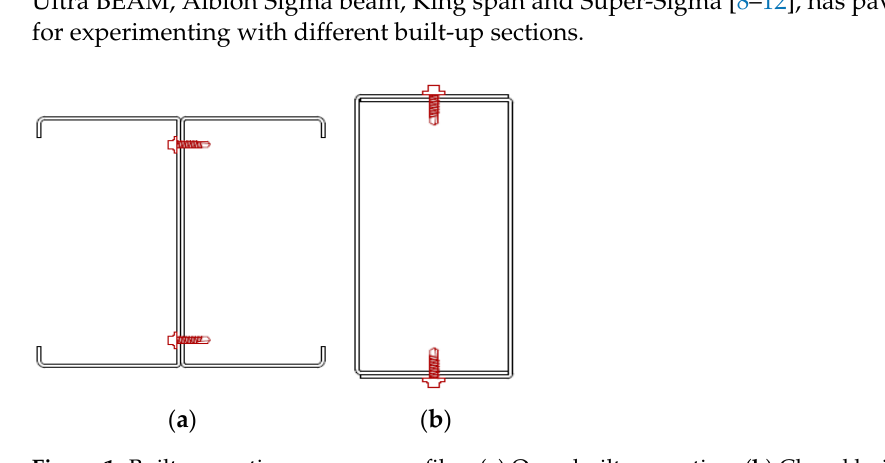
Figure 1. Built-up section common profiles: ( a ) Open built-up section; ( b ) Closed built-up section (Box type) [12].